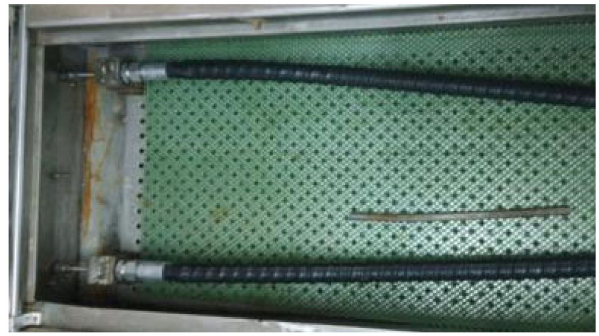
Figure 18. Two hose assembly experiments.